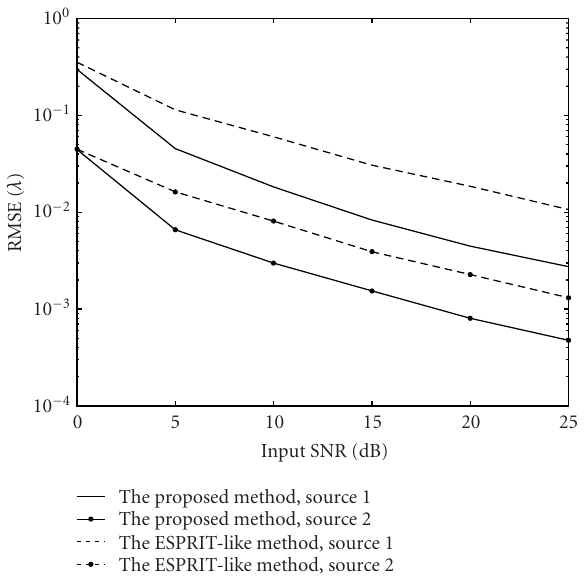
Figure 5: The RMSE of the estimated frequency over 500 Monte Carlo runs versus the number of snapshots; 14 sensors are used and the SNR is fixed at 15dB. Two equi-power sources approach the ar- ray from 38 ◦ and 20 ◦ , respectively.